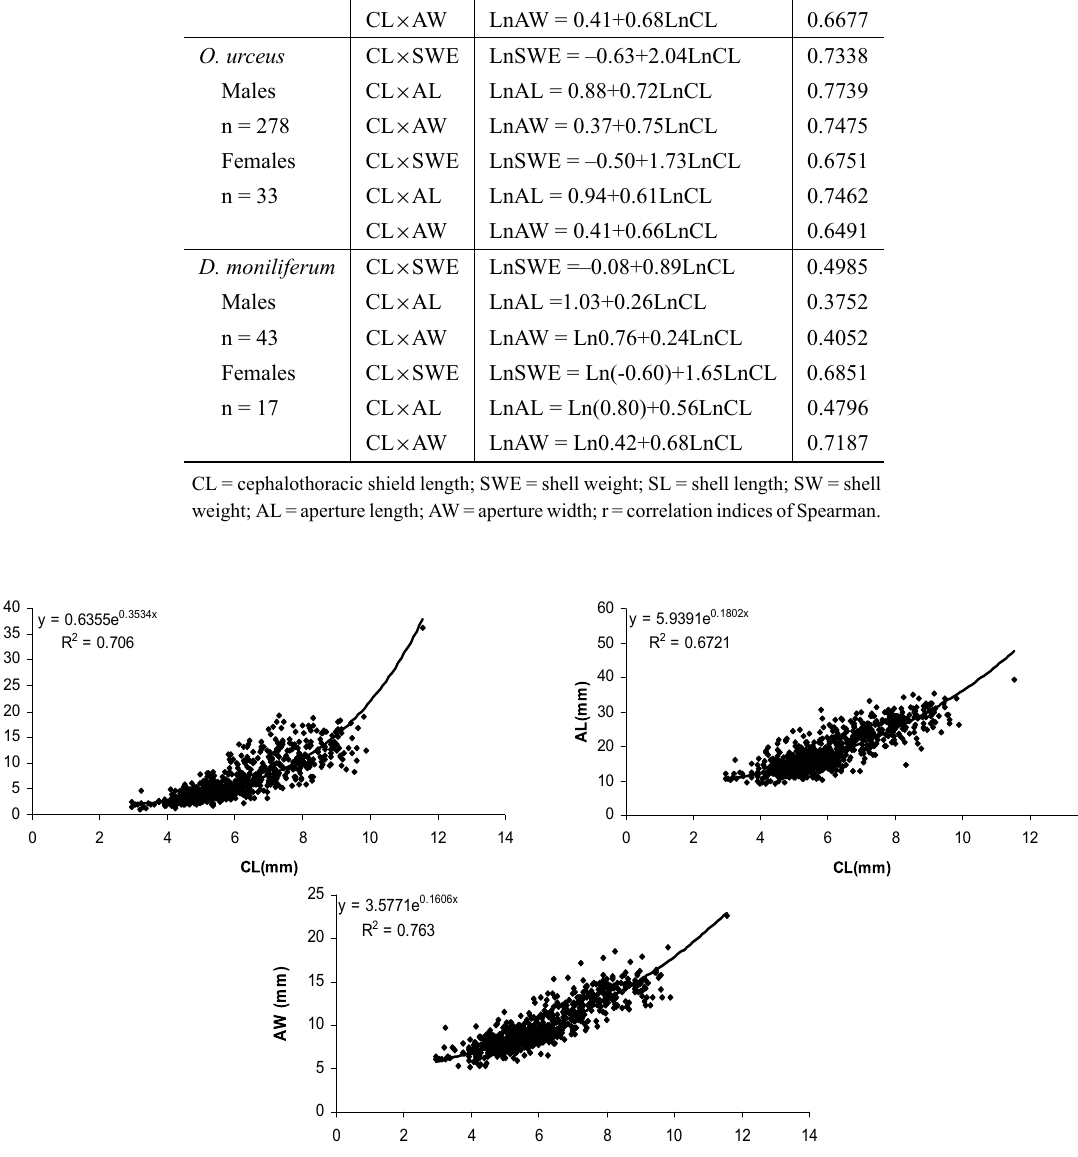
Fig. 4 – Clibanarius vittatus . Dispersion plots between hermit crab cephalothoracic shield length (CL) and variables of the most frequently occupied shell – S. haemastoma . (SWE = shell weight; AL = shell aperture length; AW = shell aperture